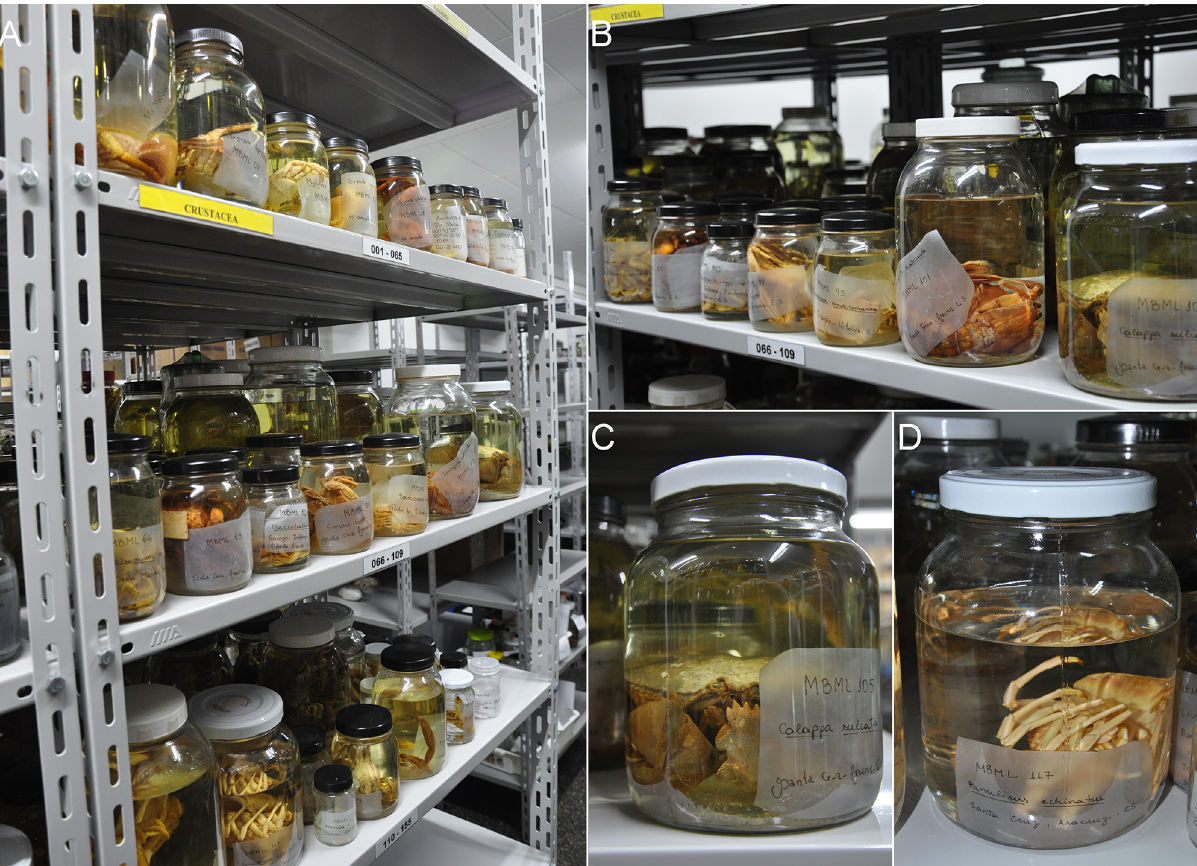
Figure 1. The Crustacea collection of INMA. A , B : View of storage shelves of the collection; C : Calappa sulcata Rathbun, 1898 (MBML 105); D : Panulirus echinatus Smith, 1869 (MBML 117). Credits to Miguel A. B. Gonçalves